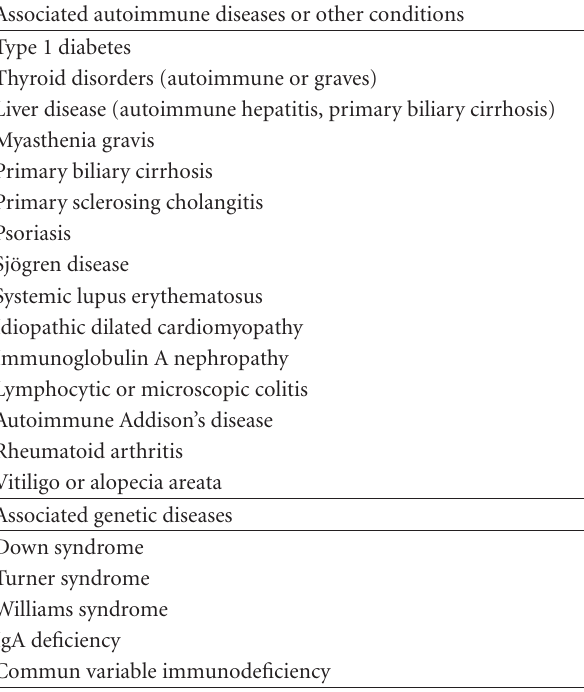
Table 2: List of possible celiac-disease-linked